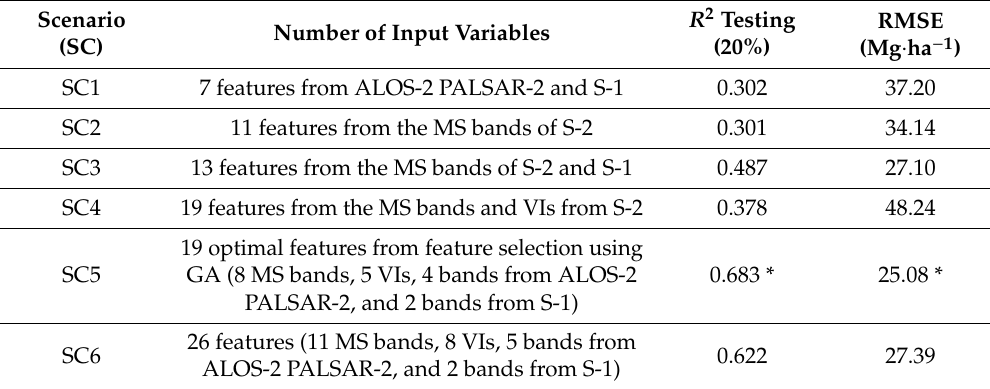
Table 7. Performance of the XGBR model with di ff erent numbers of features.